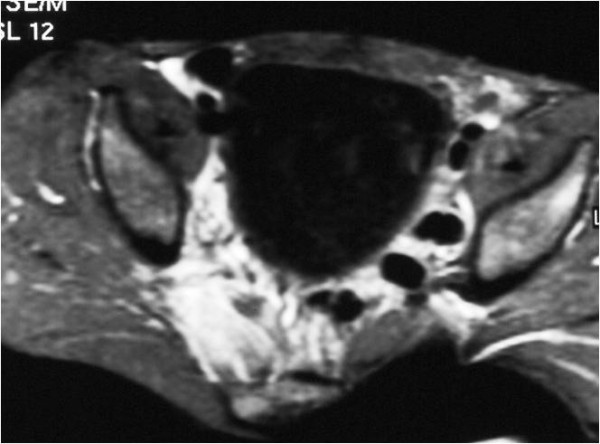
Axial spin-echo T1-weighted image with fat suppression with intravenous gadolinium contrast injection; MRI scan taken at the time of antibiotic treatment initiation. The right piriformis muscle enhances avidly after intravenous gadolinium, due to inflammation. Inflammatory changes are also depicted in the adjacent soft tissues of the pelvis.